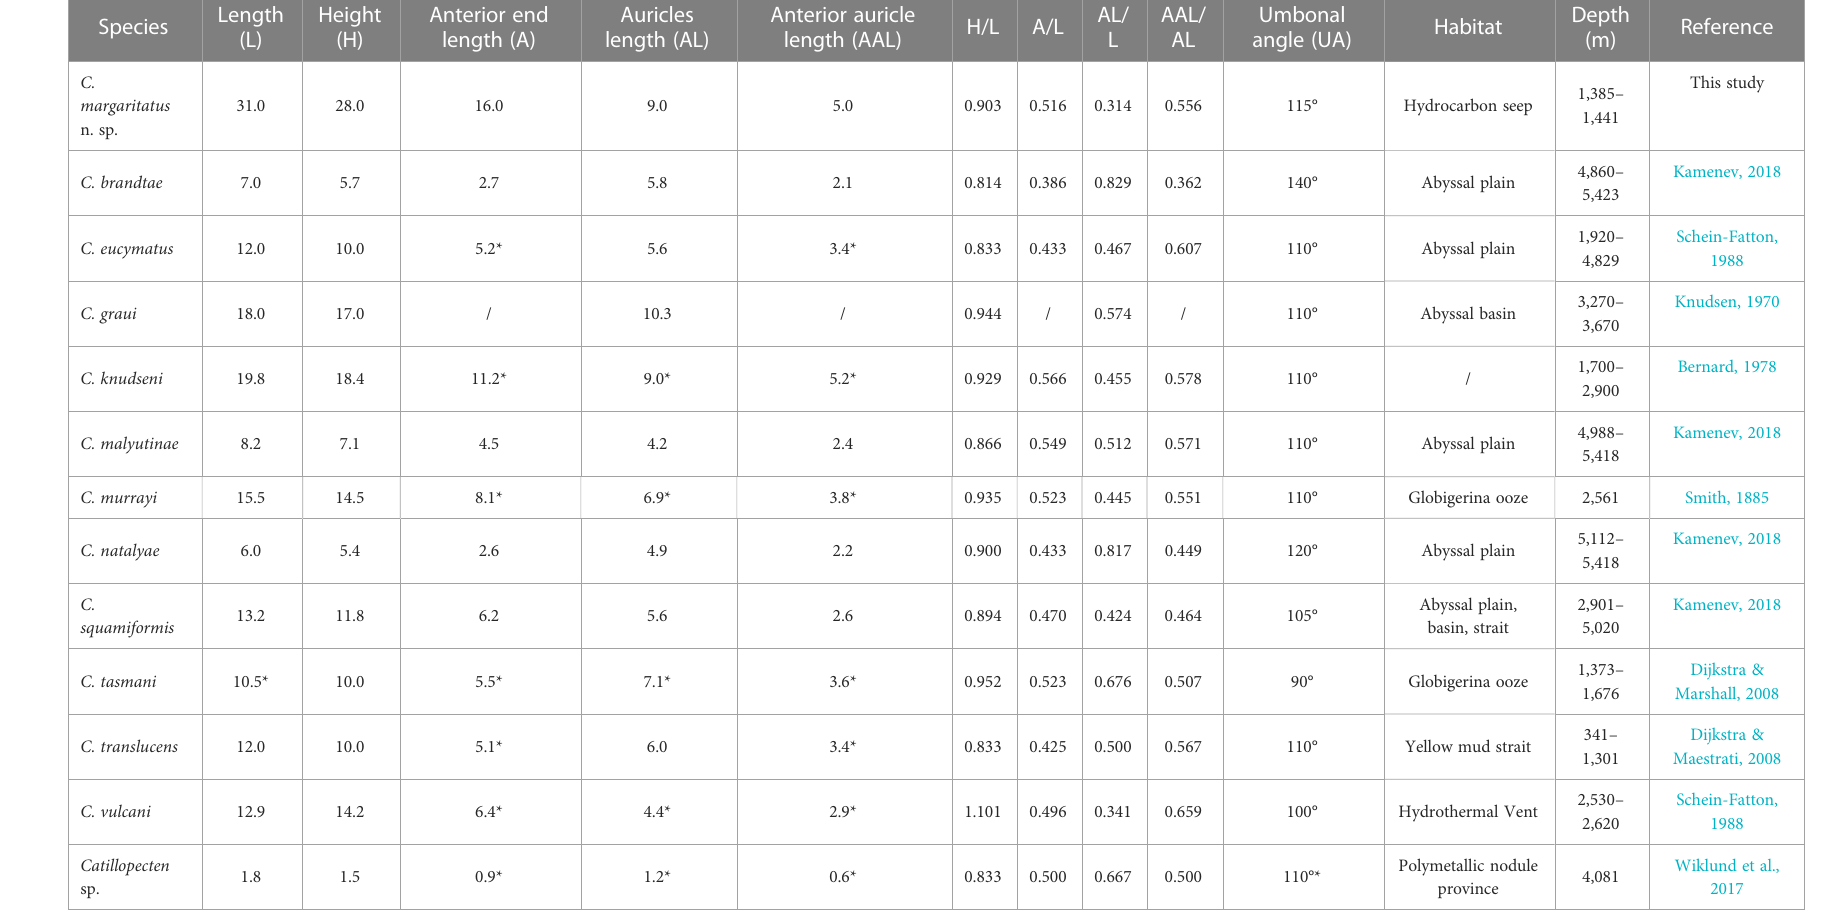
Depth Habitat (m)